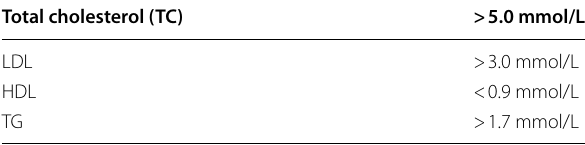
Table 1 Reference values for definition of dyslipidemia in